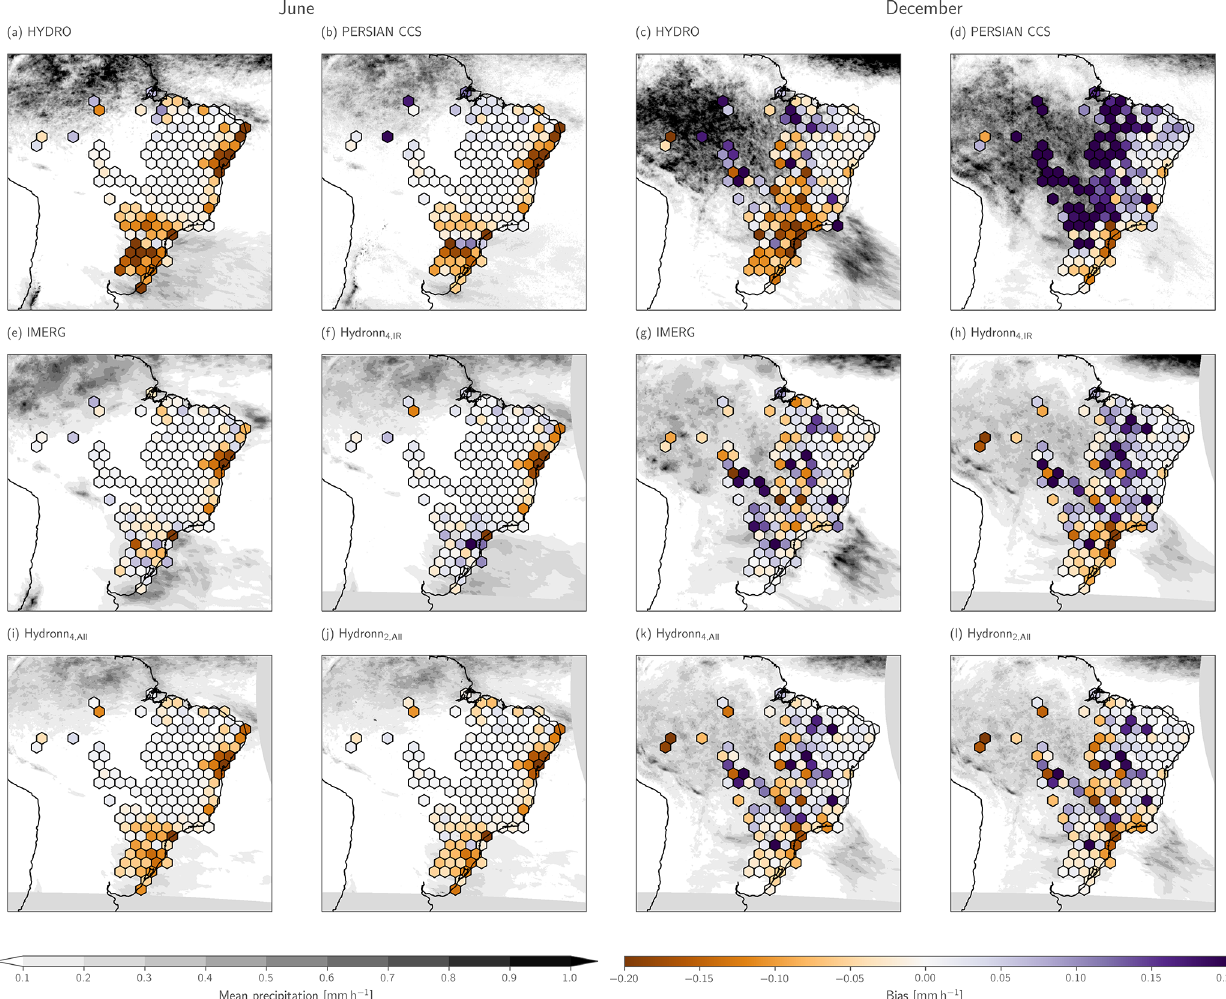
Figure 12. Retrieved mean precipitation during June and December 2020. The first two columns show the results for June. The third and fourth columns show the results for December. Shading in the background of each panel shows the spatial distribution of the mean precipitation of the corresponding retrieval. Colored hexagons show the spatial distributions of the retrieval biases with respect to the gauge